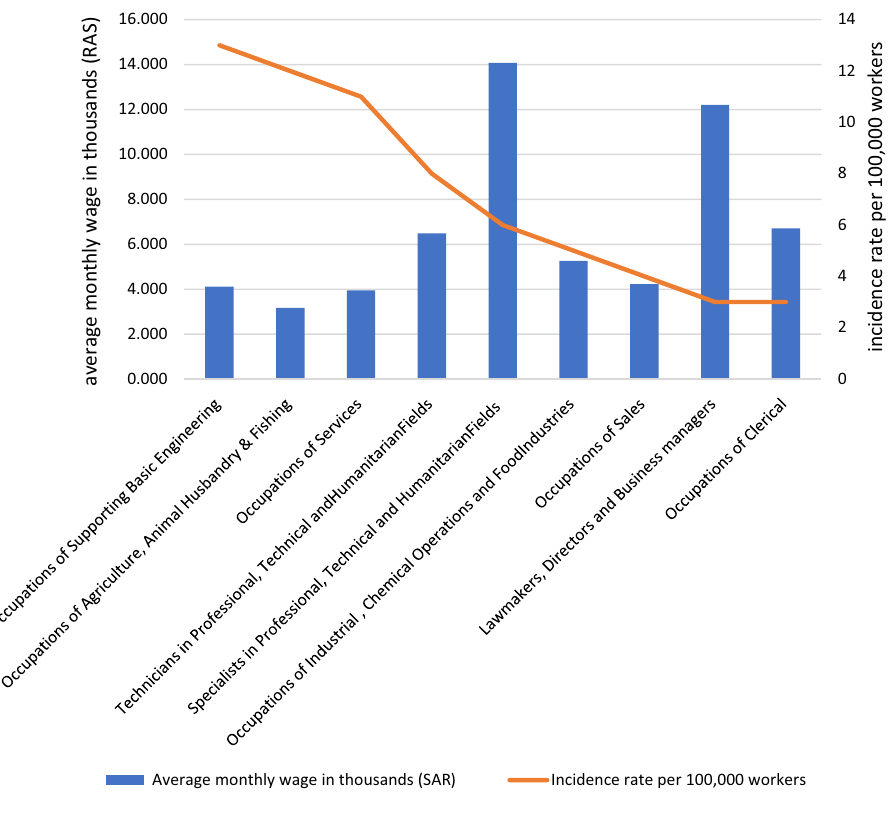
Figure 3. Average monthly wages and TB incidence rate among main occupational group in Makkah region 2016.